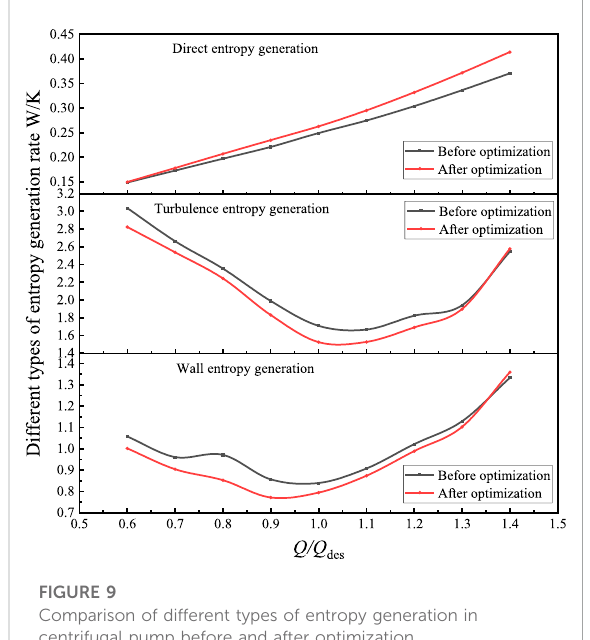
FIGURE 9 Comparison of different types of entropy generation in centrifugal pump before and after optimization.